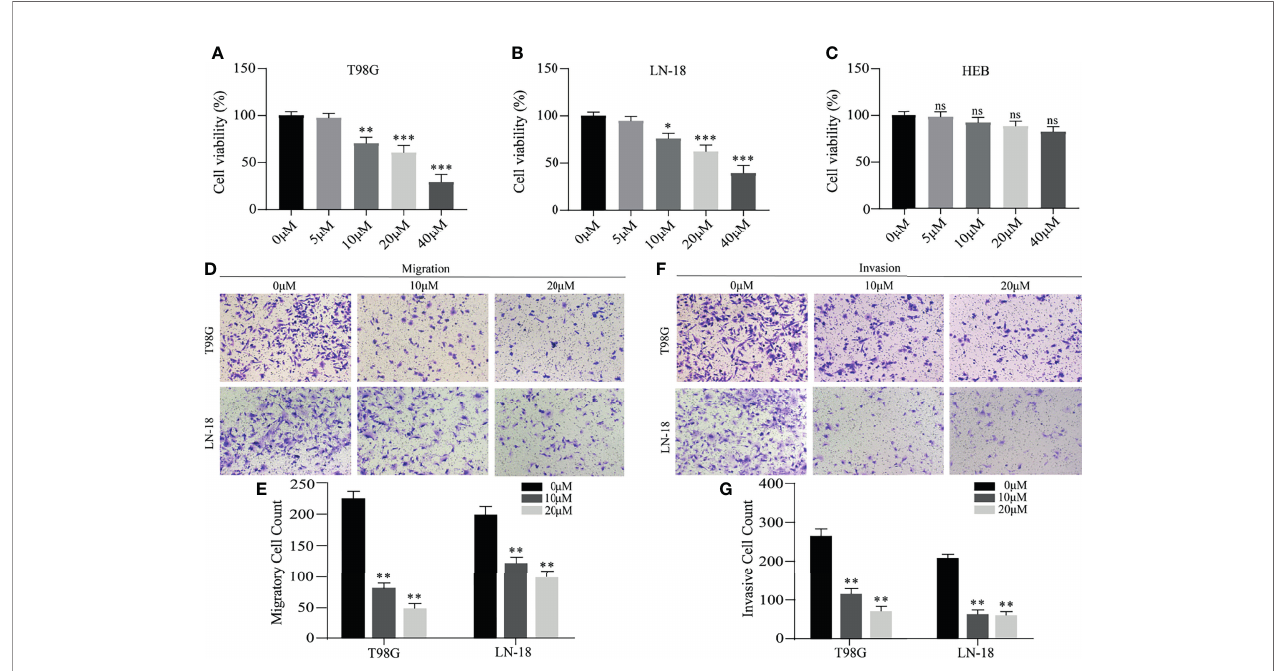
FIGURE 9 | The effects of belnacasan on cell viability, migration and invasion. (A – C) T98G, LN-18 and HEB cells were treated with different concentrations of belnacasan for 48 hours, and then CCK-8 assays were performed to determine the cell viability. * p < 0.05, ** p < 0.01, and *** p < 0.001 vs 0 m M; ns indicates no signi fi cance. (D, E) Migratory T98G and LN-18 glioma cells treated with belnacasan at proper concentrations were tested. ** p < 0.01 vs 0 m M. (F, G) Invasive T98G and LN-18 glioma cells treated with belnacasan at proper concentrations were tested. Scale bar, 200 m m. ** p < 0.01 vs 0 m